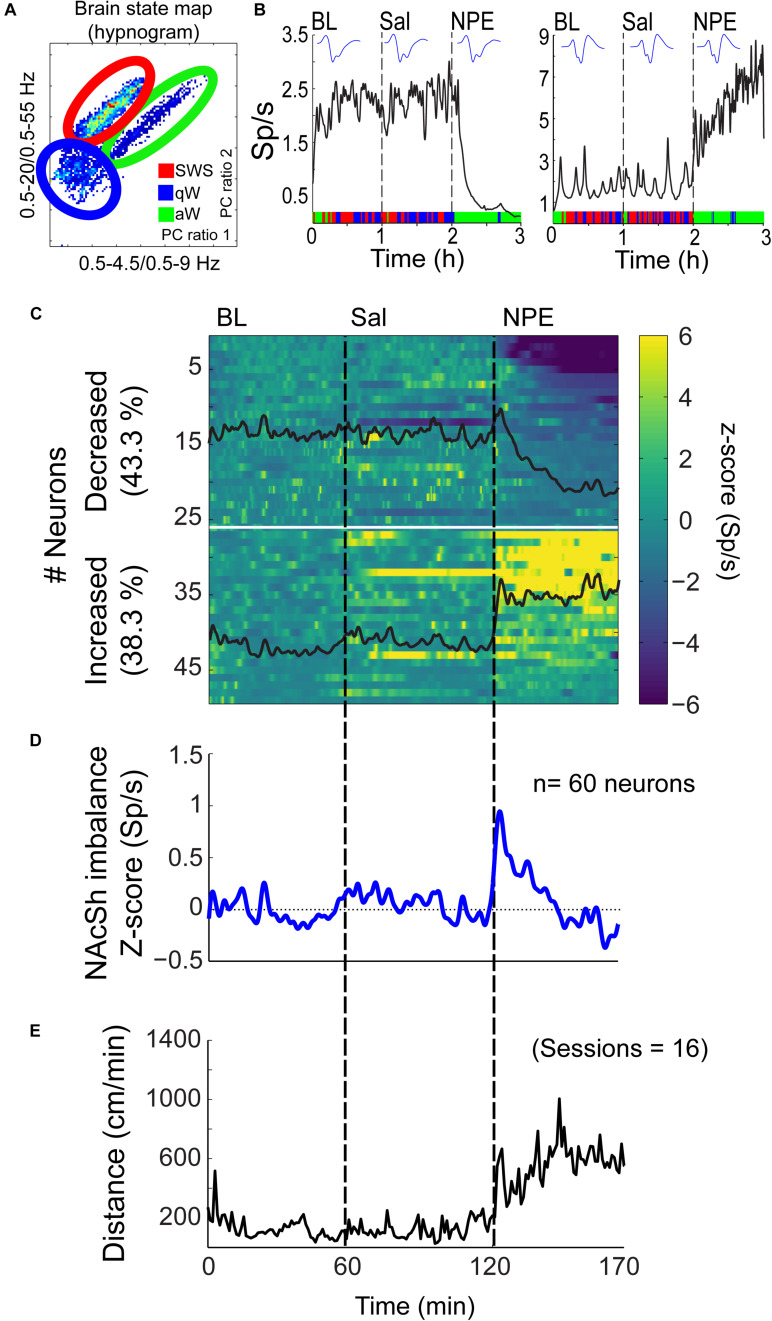
NPE modulates NAcSh spiking activity. (A) A brain state map (hypnogram) was computed from the local field potentials (LFPs) from the NAcSh, illustrating the three major behavioral states: slow-wave sleep (SWS), quiet awake (qW), and active awake (aW). Each dot represents the principal component (PC) ratio between two power intervals for each second of NAcSh’s LFP activity. Each dot falling into the red ellipsoid corresponded to periods when the animal was in SWS, and in blue and green, ellipsoids represent qW and aW brain states, respectively. (B)
Left panel: An example of one neuron exhibiting decreased firing rates (spikes/s, Sp/s) after NPE injection. The action potential waveform did not change across the session. The color bar on the x-axis represents the SWS, aW, and qW states. Right panel: A typical neuron with increasing firing rates after NPE injection. (C) A color-coded peristimulus time histogram (PSTH) of NAcSh neuronal responses of 49/60 neurons recorded during BL, Sal, and NPE epochs (vertical black lines). The horizontal white line split neurons with decreased from increased neural responses. (D) The average population PSTH activity of all 60 NAcSh neurons recorded. (E) Average locomotor activity (cm/min) obtained across 16 recording sessions.